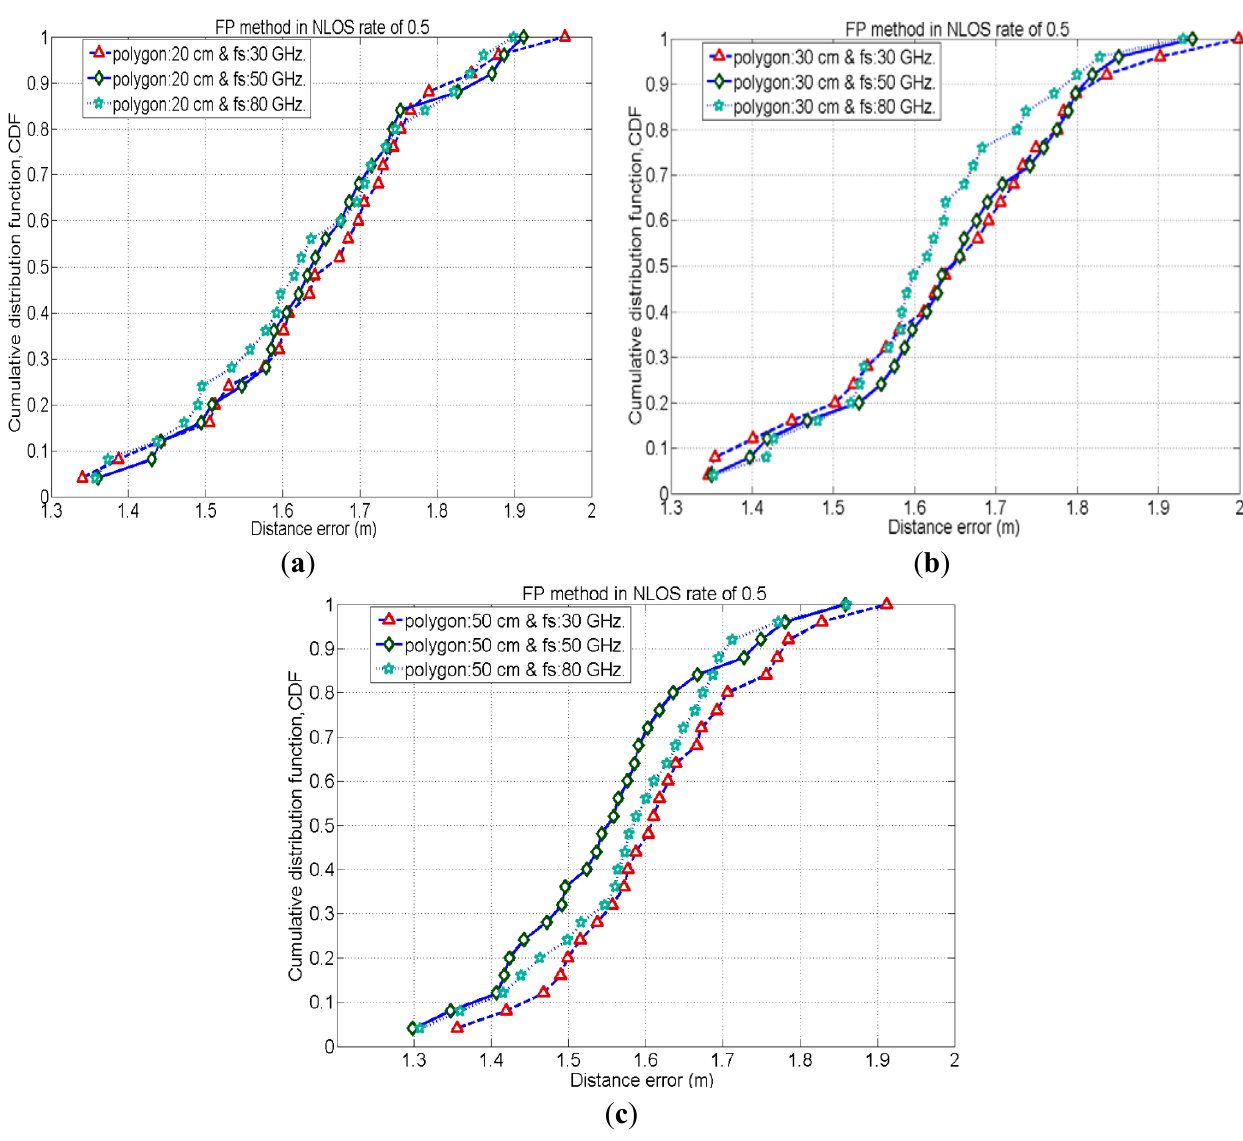
Figure 7. CDF of the distance errors for FP method in different cases with NLOS rate =